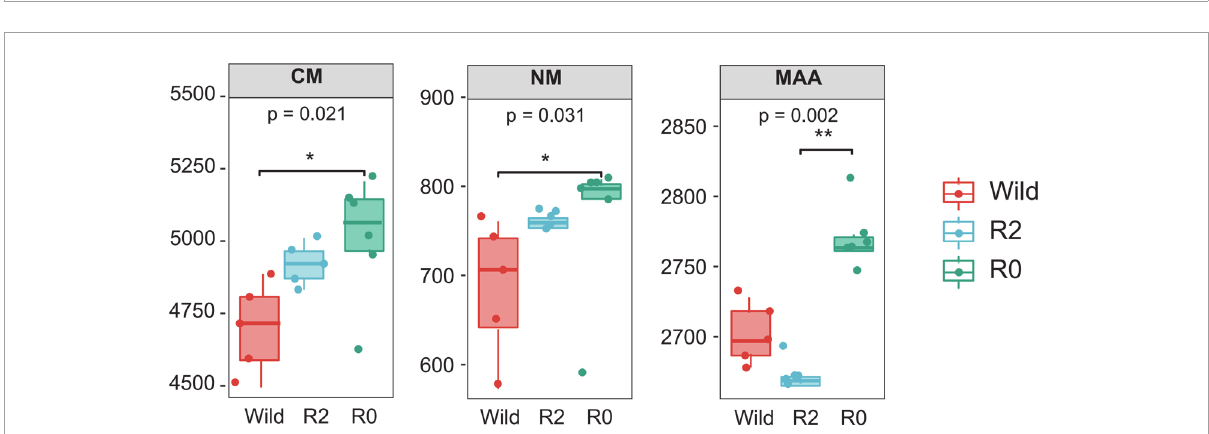
FIGURE7 The microbial functions and groups with significant differences ( p < 0.05), CM, Carbohydrate metabolism; NM, Nucleotide metabolism; MAA, Metabolism of other amino acids. * represents significant and ** represents very